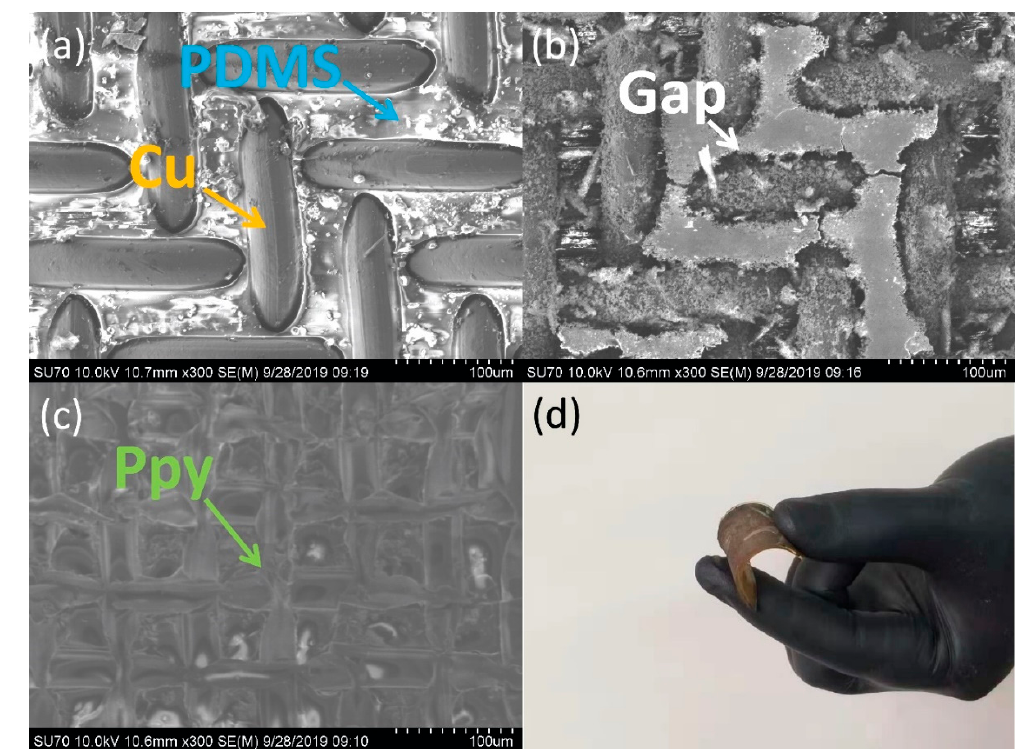
Figure 2. The characterization of self-powered sour sensor. ( a ) SEM image of copper-wire-mesh/PDMS film. ( b ) SEM image of copper-wire-mesh/PDMS film after wet-etching. ( c ) SEM image of the device after electrochemical deposition. ( d ) The optical image of the self-powered sour sensor.